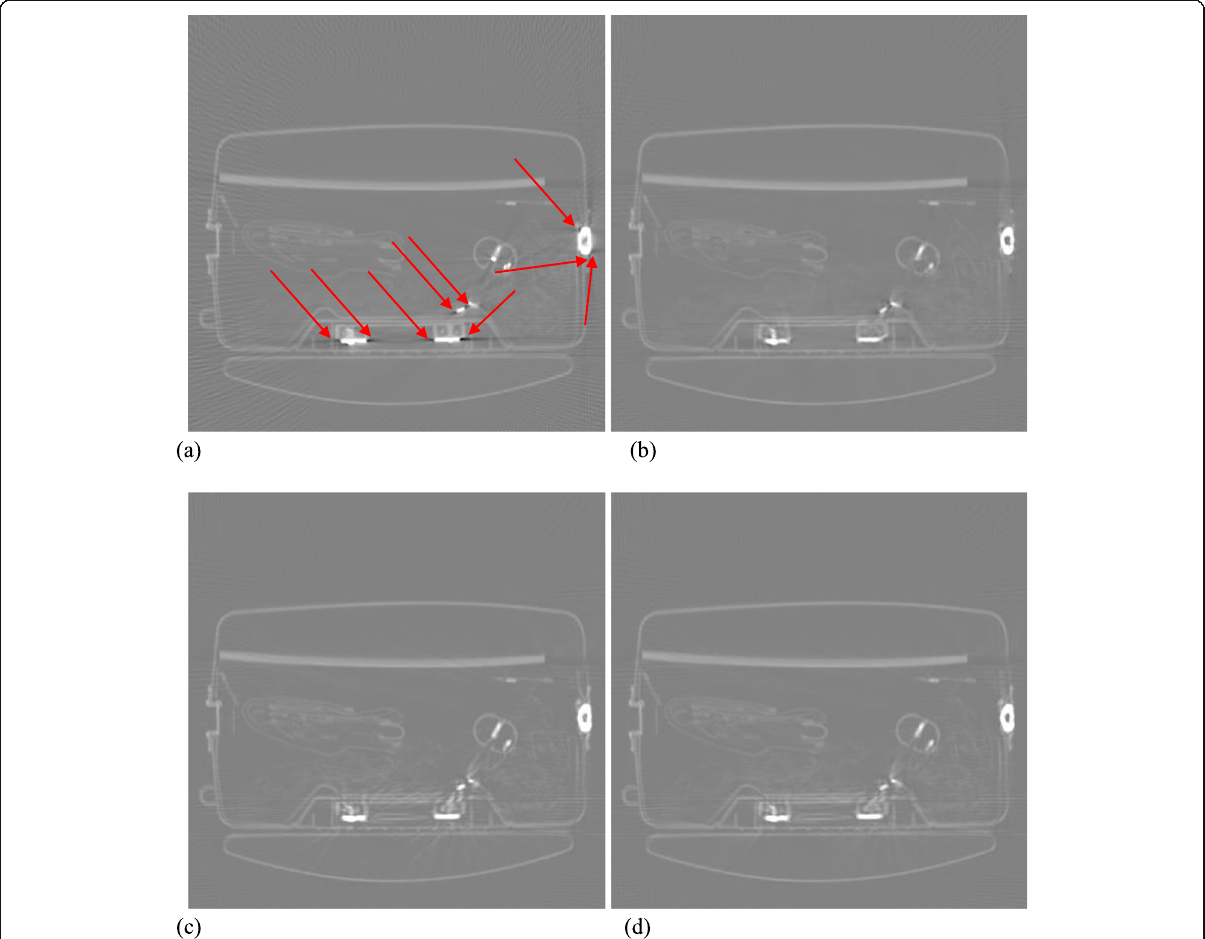
Fig. 3 Reconstruction of bag #3. a Raw FBP; b TV-term only; c Non-negativity-term only; d Combined. Some artifacts are marked by the red